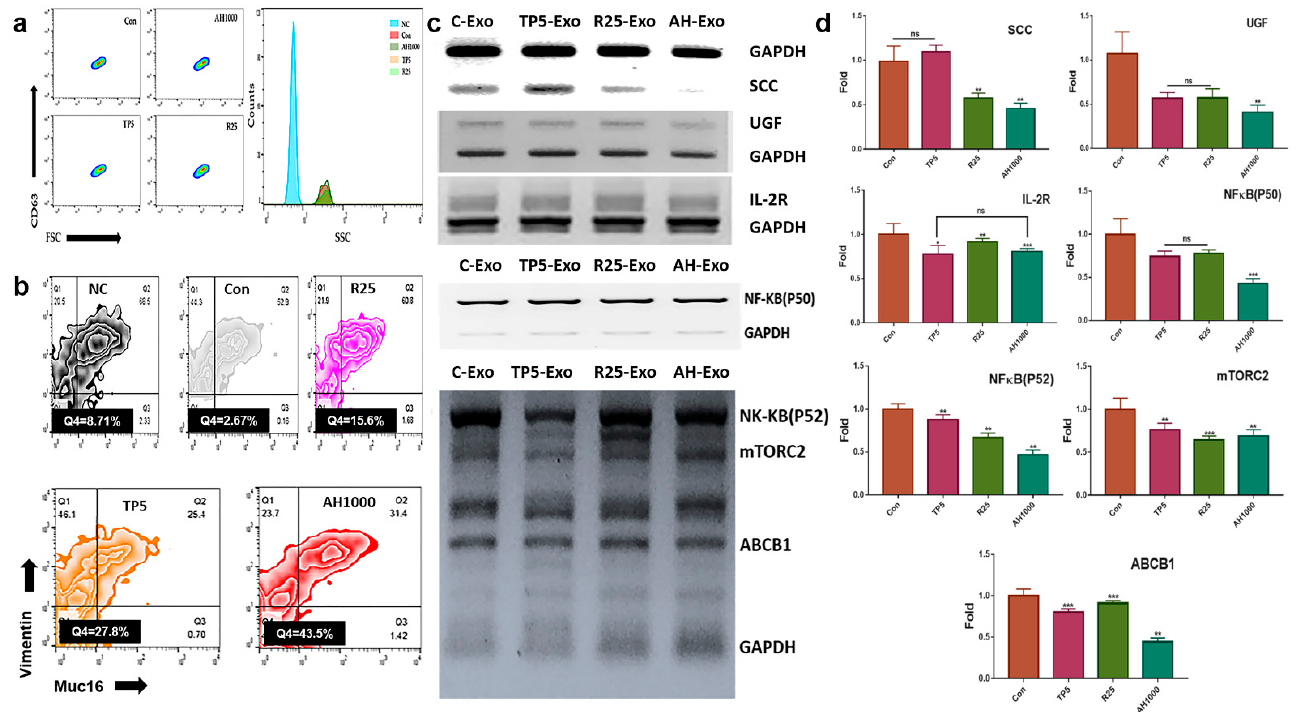
Figure 3. Expression of cancerous markers in endometrial cancer (EC) cells in the presence of induced exosomes; ( a ) The histograms indicate the induced exosomes from EC cells. NC was not stained with FITC anti-CD63. ( b , c ) The gated population; CD63 + exosomes were analyzed in the presence of FSC and SSC. The graphs indicate the expression of the markers in EC cells in the presence of exosomes. ( d ) Muc16 + and vimentin + cell count in EC cells in the presence of exosomes; 5 µ g/mL tocopherol- α (TP5), 25 µ g/mL rutin (R25), and 100, 500, and 1000 µ g/mL A. helianthus extract (AH100, AH500, and AH1000, respectively). ns: not significant; * p < 0.05; ** p < 0.01; *** p < 0.001.